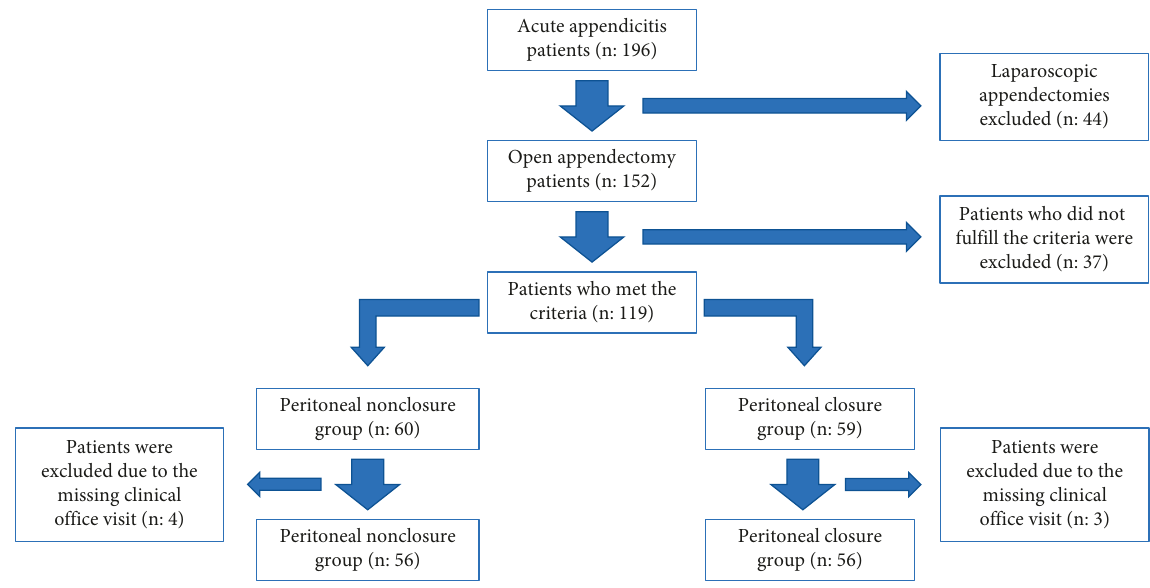
Figure 1: Flow diagram of patients enrolled in the study. Table 1: Demographic data, operation time, VAS scores for postoperative pain, and postoperative complication details of the